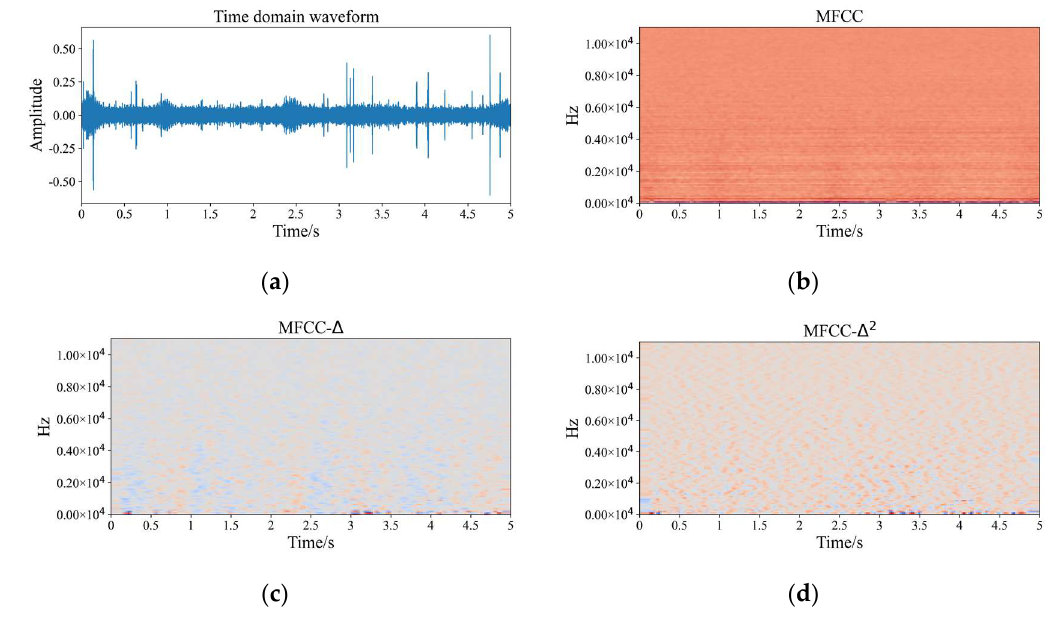
Figure 5. The 3D dynamic MFCC is generated from the time domain waveform signal. ( a ) The time- domain waveform; ( b ) MFCC feature; ( c ) delta MFCC feature; ( d ) double-delta MFCC feature .